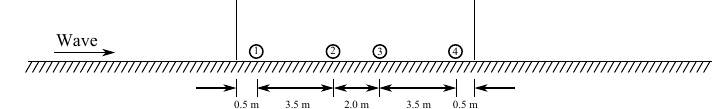
Figure 6. Wiggert experimental setup.